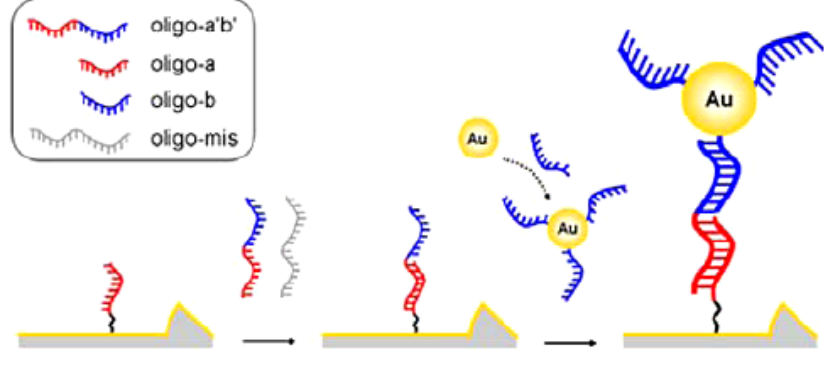
Figure 8. Sketch diagram of the microcantilever DNA biosensor using AuNPs as signal-